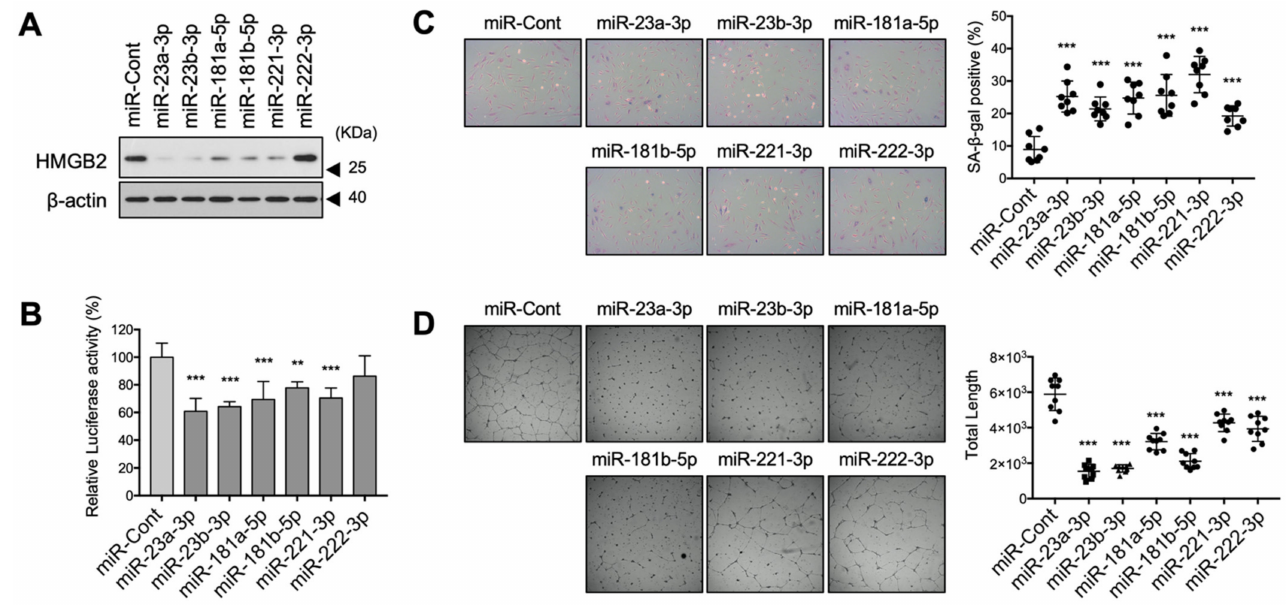
Figure 5. MicroRNAs targeting HMGB2 regulated cellular senescence in MVECs. ( A ) Proliferating MVECs (PDL28) were transfected with the selected miRNA mimics, and the HMGB2 protein level was examined via immunoblot analysis. ( B ) Luciferase activities were measured after co-transfection with Luc reporter gene fused with 3 (cid:48) UTR sequence of HMGB2 and the indicated miRNAs into 293T cells. ( C ) Senescence in MVECs was determined via SA- β -gal staining and the proportion of SA- β -gal-positive cells was compared statistically. ( D ) The effect of miRNA mimics on the angiogenic activity of MVECs was analyzed via in vitro tube formation assays and the total length of tube-like structures in a field was statistically compared. ** p < 0.01, *** p < 0.001.